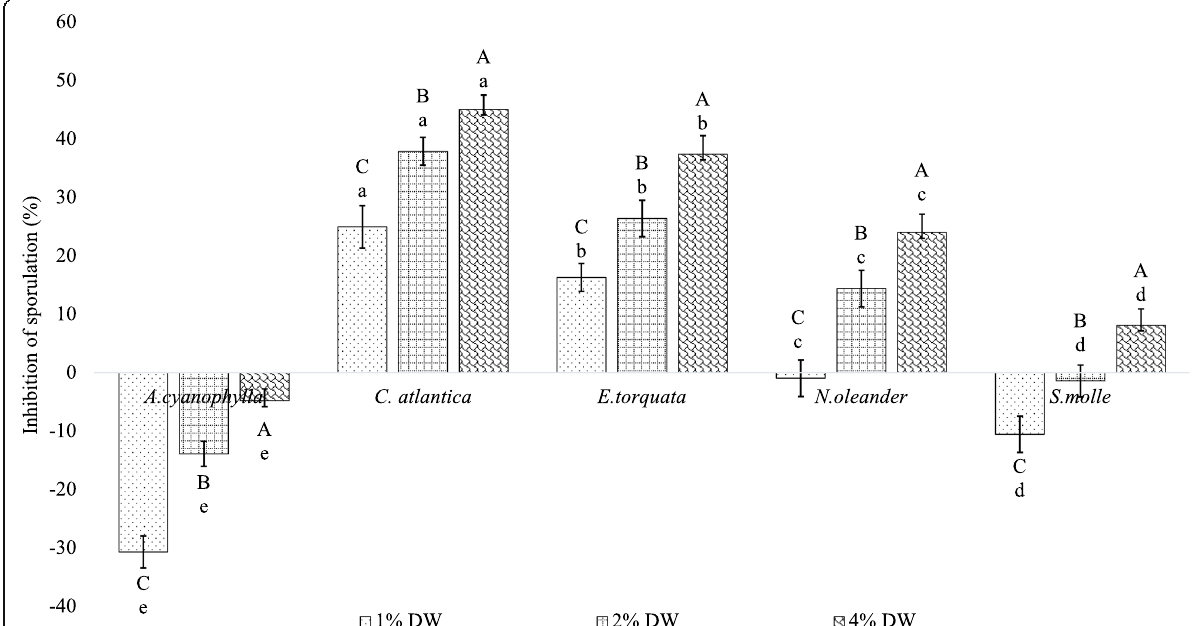
Fig. 3 Effect of different percentage of plant DW on Foa sporulation. Plant species and extract concentration had significant effects on the percentage of sporulation inhibition (one-way ANOVA, p < 0.05). Each bar represents the mean of five replicate plates per concentration. Within each plant species, bars followed by the same uppercase letters indicate no significant differences among extract concentrations while within each concentration, bars followed by the same lowercase letters indicate no significant differences among plant species (Bonferroni tests, p < 0.05). Error bars represent standard